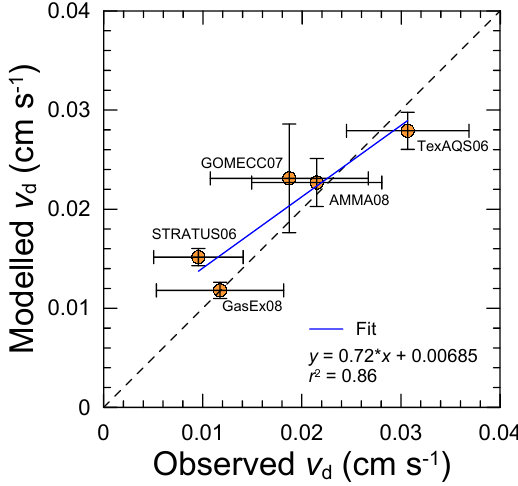
Figure 8. Scatter plot of the ozone dry deposition velocities ( v d ) obtained from the five cruise experiments versus the correspond- ing values obtained from the ACCESS-UKCA model using the new two-layer scheme (Eq. 16). Each point corresponds to the average over all values from one experiment. The error bars represent 1 stan- dard deviation variation. Horizontal error bars are for the observed values and the vertical ones are for the modelled